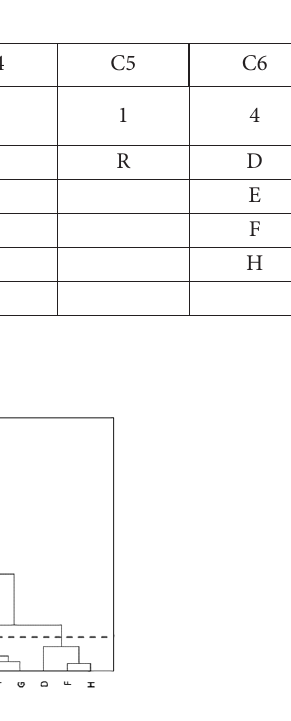
Figure 2. Dendrogram Czech Republic (source: authors) Table 4. Clusters of Czech Republic (source: